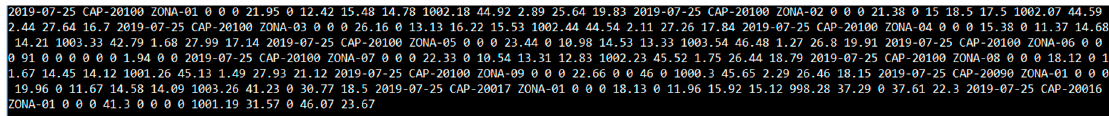
Figure 7. Formatted string referring to a one-day sample in Milan.